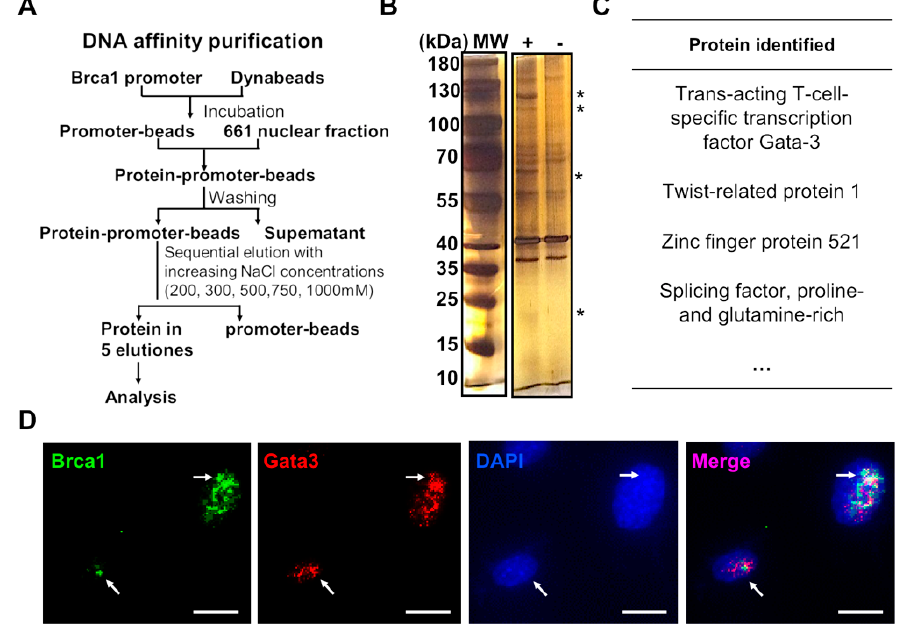
Figure 3. The transcription mechanisms of Brca1 expression. ( A ) A summary of the experimental procedures used for DNA affinity purification assays. ( B ) Several bands specifically appeared (asterisk) in the presence of the Brca1 promoter (+), but disappeared in the absence of the Brca1 promoter (-). ( C ) Proteins that might be related to transcriptional mechanisms were identified by mass spectrometry. ( D ) Gata3 (red) is strongly expressed and colocalized with Brca1 (green) in the cellular nuclei of 661W cells. Scale bars represent 10 µ m. The asterisks indicate statistically significant differences (* p < 0.05, ** p < 0.01). The white aroows indicate colocalization of Brca1 and Gata3 in the nucleus.